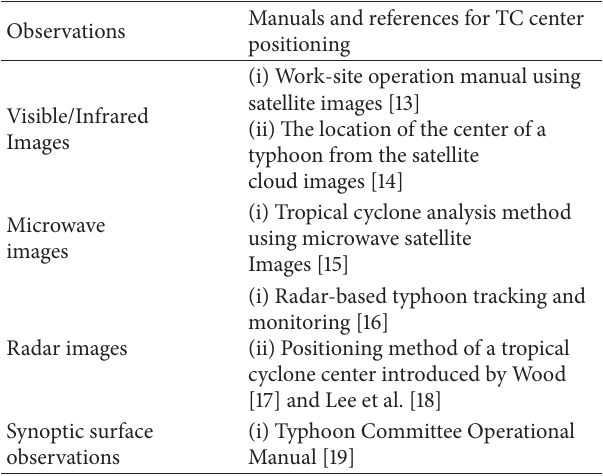
Table 2: References for tropical cyclones analysis using visible/ infrared, microwave and radar imagery, and synoptic surface